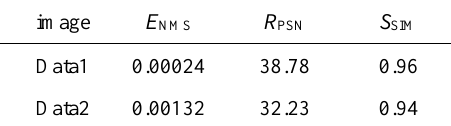
Table 1. image filtering results evaluation statistics